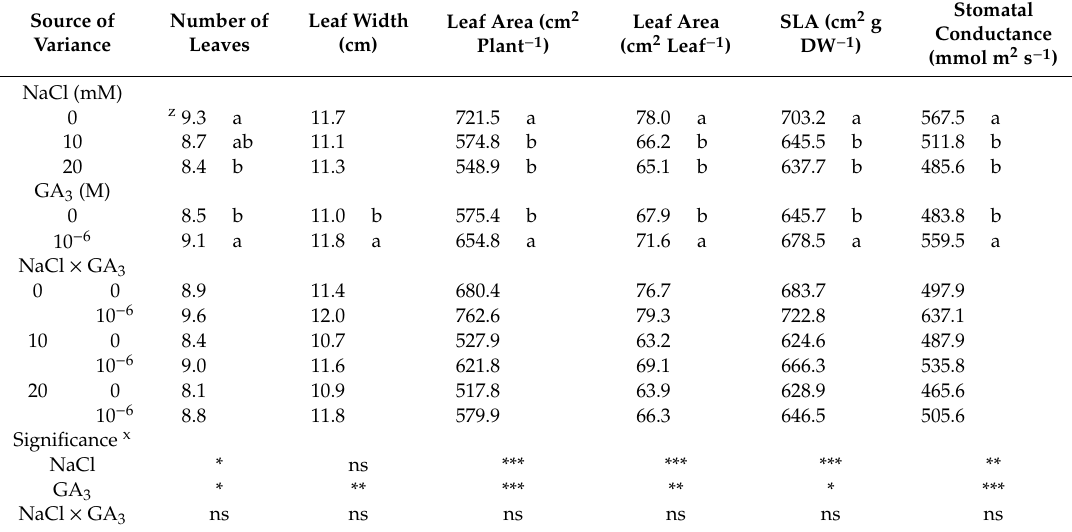
Table 3. Leaf characteristics of leaf lettuce plants grown in nutrient solutions containing di ff erent levels of NaCl and GA 3